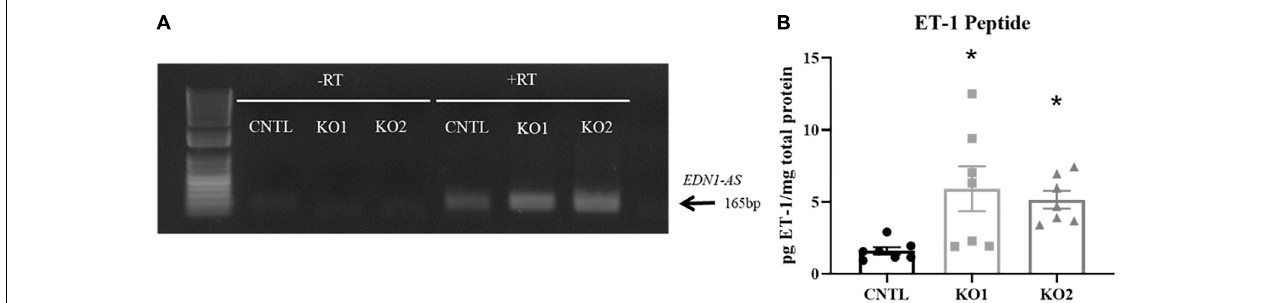
protocol on the KO cell lines in addition to the CNTL cells. The CRISPR KO cells had higher expression of EDN1-AS compared to CNTL cells ( Figure 7A ). Secreted endothelin-1 peptide (ET-1)